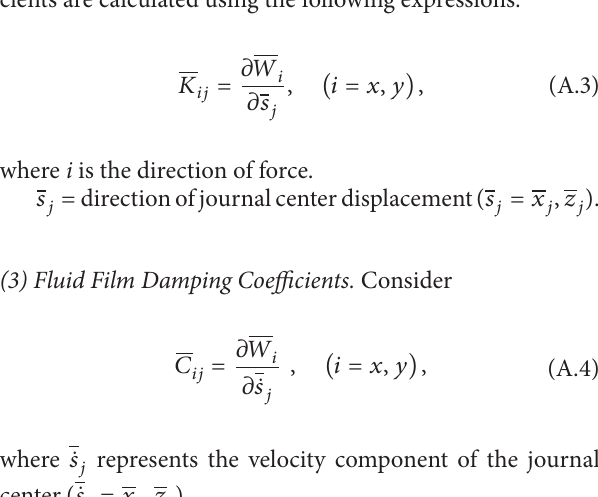
Figure 14: Variation of critical mass M 𝑐 as a function of character- .” istics length “ l m